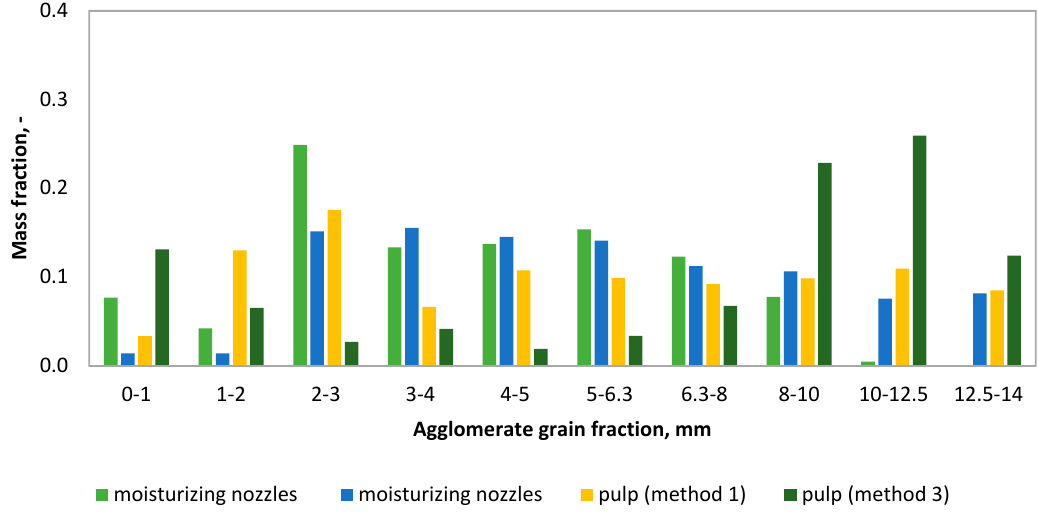
Figure 5. Comparison of disc granulation methods with the addition of wet gypsum.